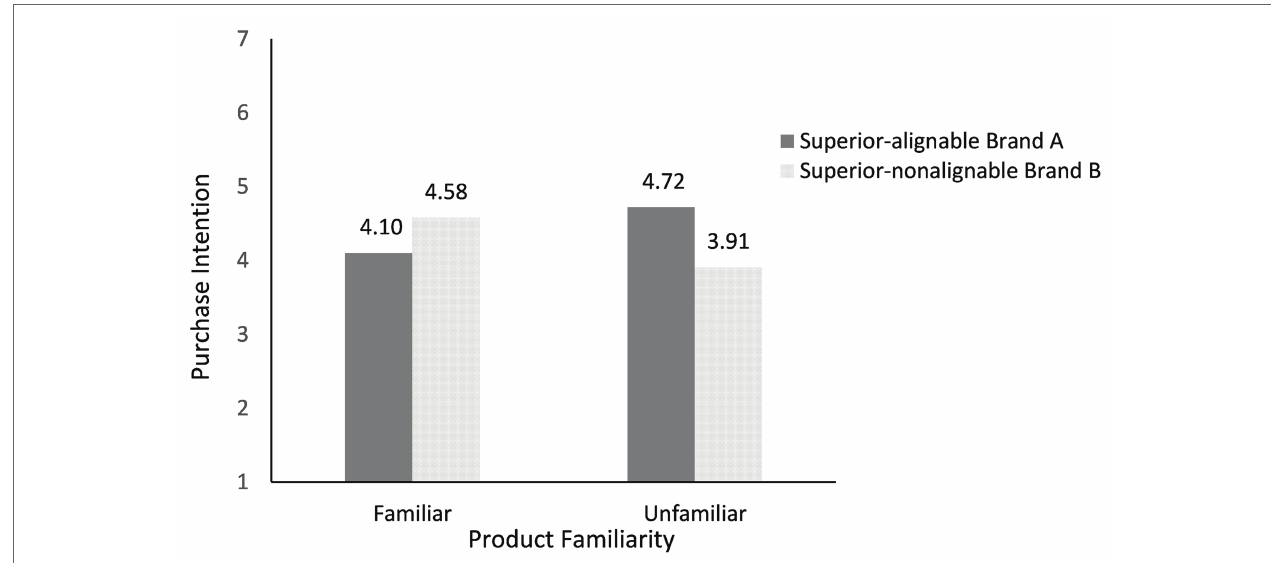
FIGURE 2 | Effects of product familiarity and attribute alignability on purchase